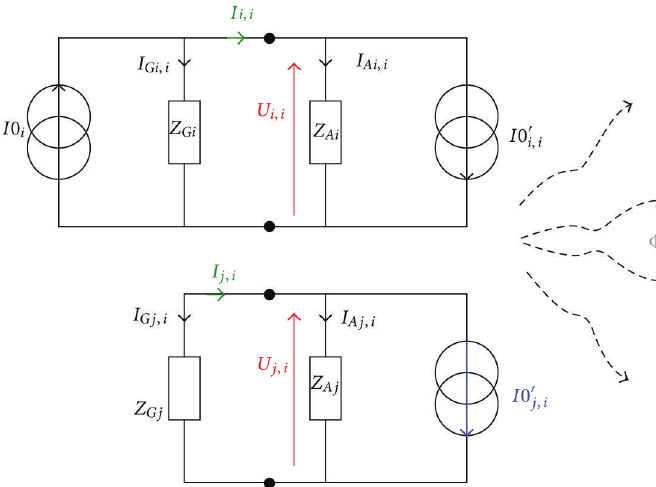
Figure 3: Equivalent electrical scheme of one antenna fed ( i ) with another loaded with the impedance Z Gj .